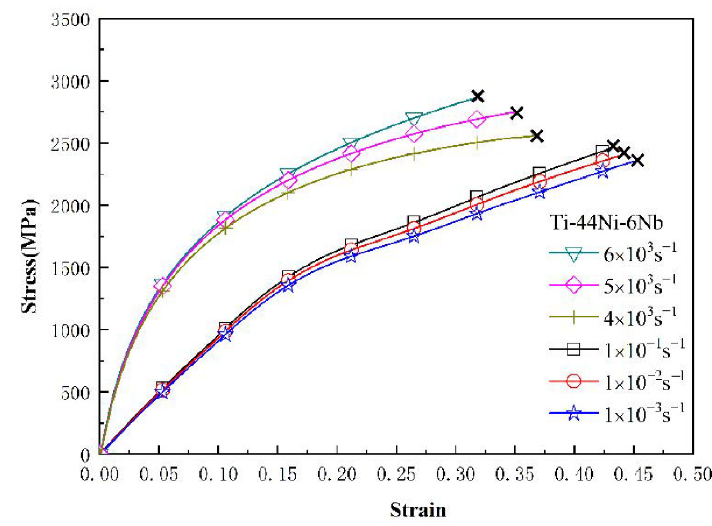
Figure 5. Low strain rate and high strain rate deformation of TiNi 44 Nb 6 alloy.